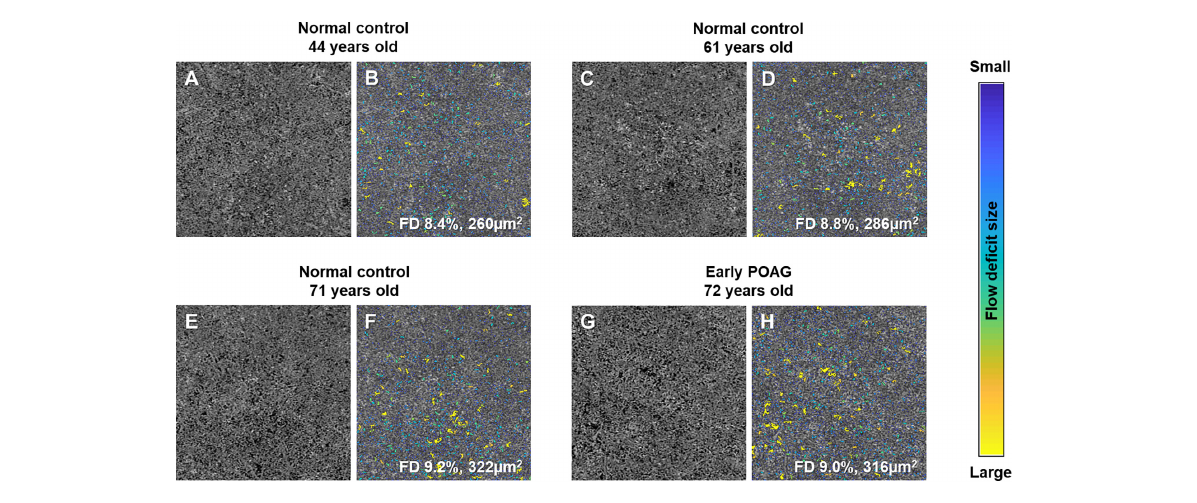
FIGURE2 Representative choriocapillaris OCTA 3 × 3 mm2 images (A,C,E,G) and their corresponding color-coded maps (B,D,F,H) . The density and average size of choriocapillaris flow deficits (FD) in normal controls increases with age, where it is 8.4% and 260 µ m 2 in the 44-year-old subject (A,B) , followed by 8.8% and 286 µ m 2 in the 61-year-old subject (C,D) , and highest at 9.2% and 322 µ m 2 in the 71-year-old (E,F) . Similar density and average size of choriocapillaris FD can be seen in a 72-year-old patient with mild primary open angle glaucoma (POAG; visual field mean deviation of − 2.85 dB; G and H; 9.0% and 316 µ m 2 ) and a 71-year-old normal control (E,F ; 9.2% and 322 µ m 2 )